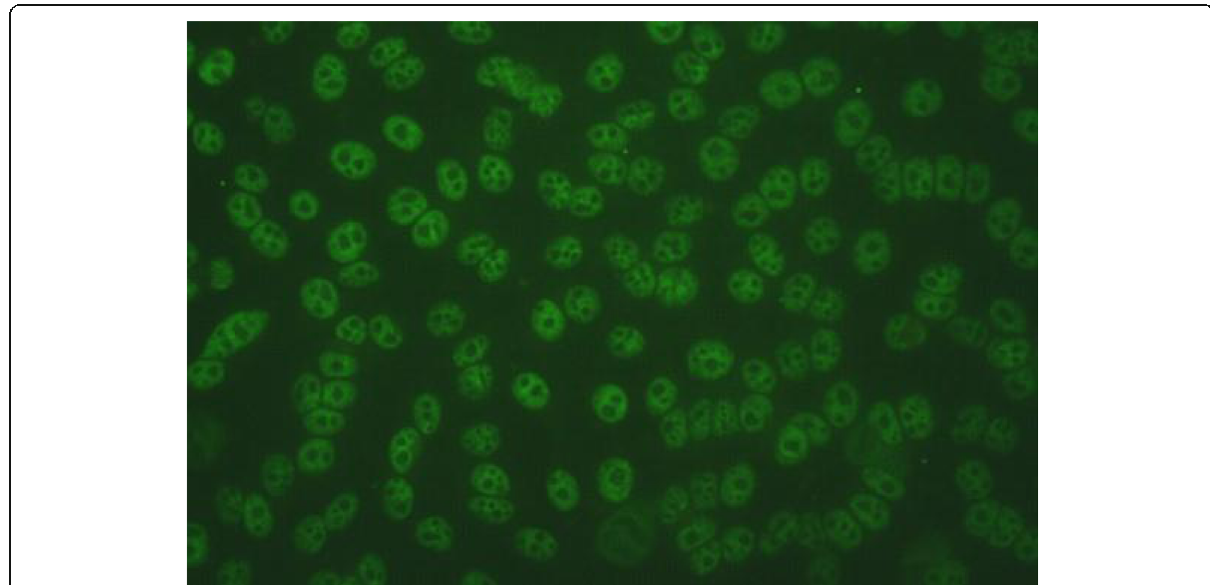
Fig. 1 Indirect immunofluorescence staining of HEp-2 cells exhibiting the nuclear fine speckled pattern of anti-Ro/SSA and anti-La/SSB antibodies (400x). Legend: Source: Central Laboratory Division and Medical Investigation Laboratory #17, Clinical Hospital, School of Medicine, University